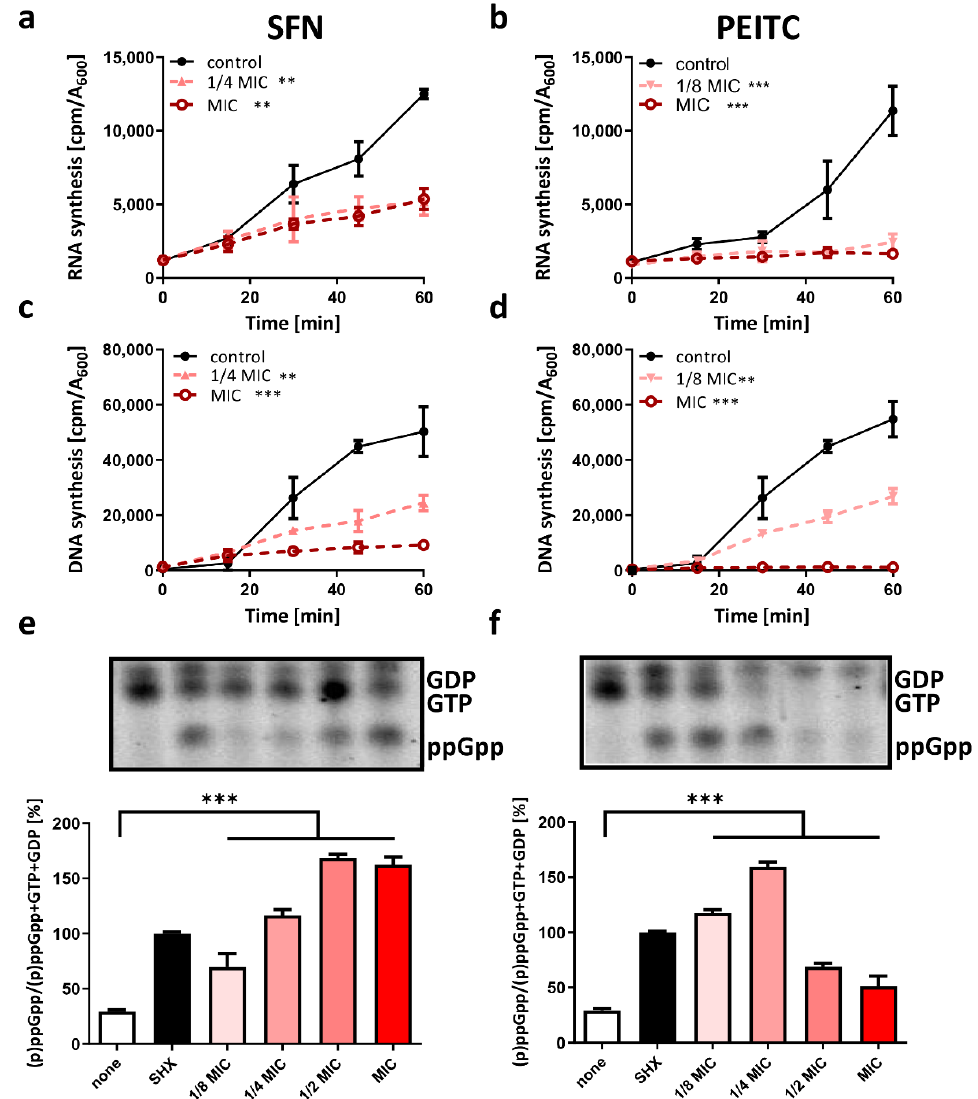
Figure 3. SFN and PEITC impair nucleic acid synthesis and activate stringent response and (p)ppGpp alarmone accumulation in V. cholerae . The effect of SFN ( a ) and PEITC ( b ) on RNA synthesis was assessed in [ 3 H]uridine incorporation assay. The effect of SFN ( c ) and PEITC ( d ) on DNA synthesis assessed in [ 3 H]thymidine incorporation assay. The (p)ppGpp alarmone level in cells treated (15 min) with SFN ( e ) and PEITC ( f ). Bacteria were grown in MOPS labeling medium in the presence of 150 µCi/mL [ 32 P]orthophosphoric acid with various concentrations of ITC or starved for amino acids by the addition of SHX. The labeled guanosine nucleotides separated on TLC are presented in the panels. The percentage of ppGpp in the total pool of guanosine nucleotides in various conditions is presented on the graphs. The results presented are mean values from 3 independent experiments. The significance of differences between the results and the control was tested using the Student ’ s t -test. Statistical significance is marked with asterisks: *** p < 0.001; ** p < 0.01.